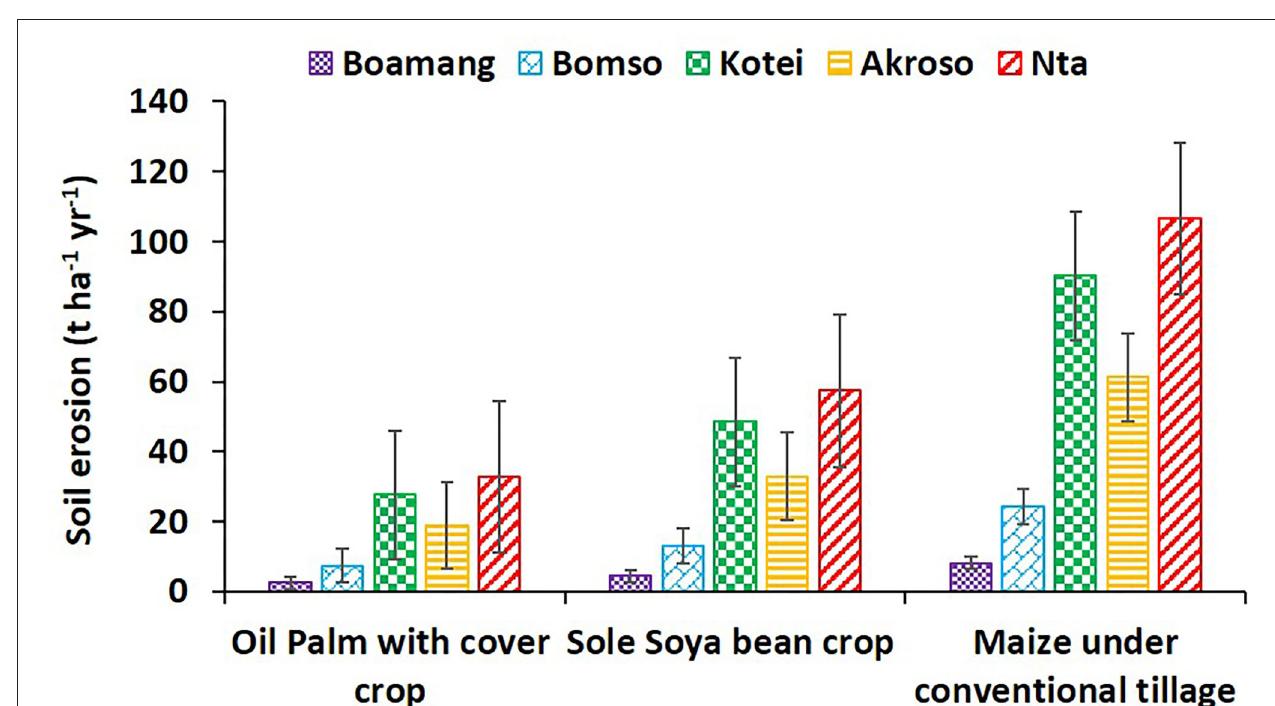
FIGURE 3 | Estimated soil losses under different land cover options.